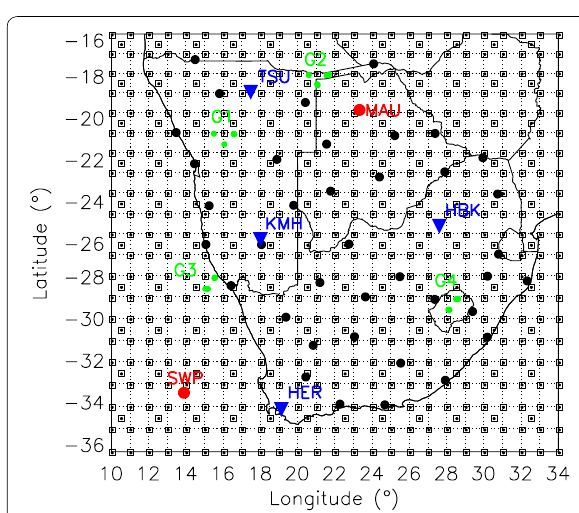
Fig. 2 Data centres for model input data. The data bins ( 0.2 ◦ × 0.2 ◦ ) used for satellite input data (represented by square shapes), the mid- dle of each data bin represents a data centre (small dots). The input data are the averages of recorded values within 1 day in the same bin at different altitudes between 300 and 380 km. The big black dots are geomagnetic repeat stations. The two red big dots are locations at the ground level used in the evaluation of the new SACFM-2 model. The four groups of green dots are the selected points for independent data at satellite altitude (G1, G2, G3 and G4) used in the evaluation of the SACFM-2 model. The four blue triangles are the permanent observatories HER, HBK, TSU and